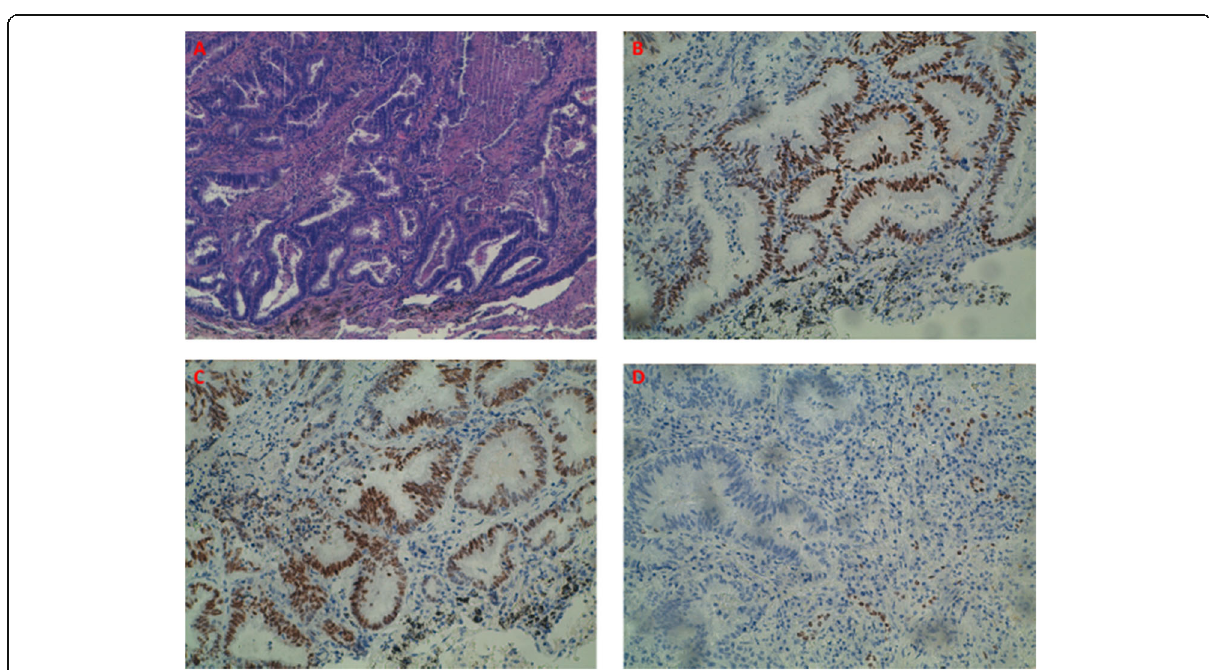
Fig. 4 Histological examination of pulmonary metastasectomy, showing tumoral cells colored with hematoxylin-eosin ( a ), positivity for estrogen receptor (ER) ( b ), positivity for paired box 8 (PAX8) ( c ), and negativity for thyroid transcription factor 1 (TTF-1) ( d